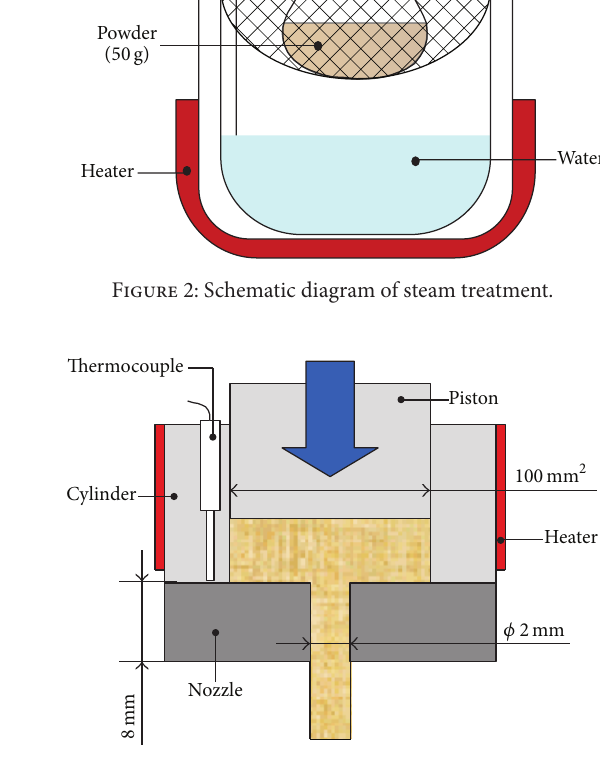
Figure 3: Schematic diagram of the capillary